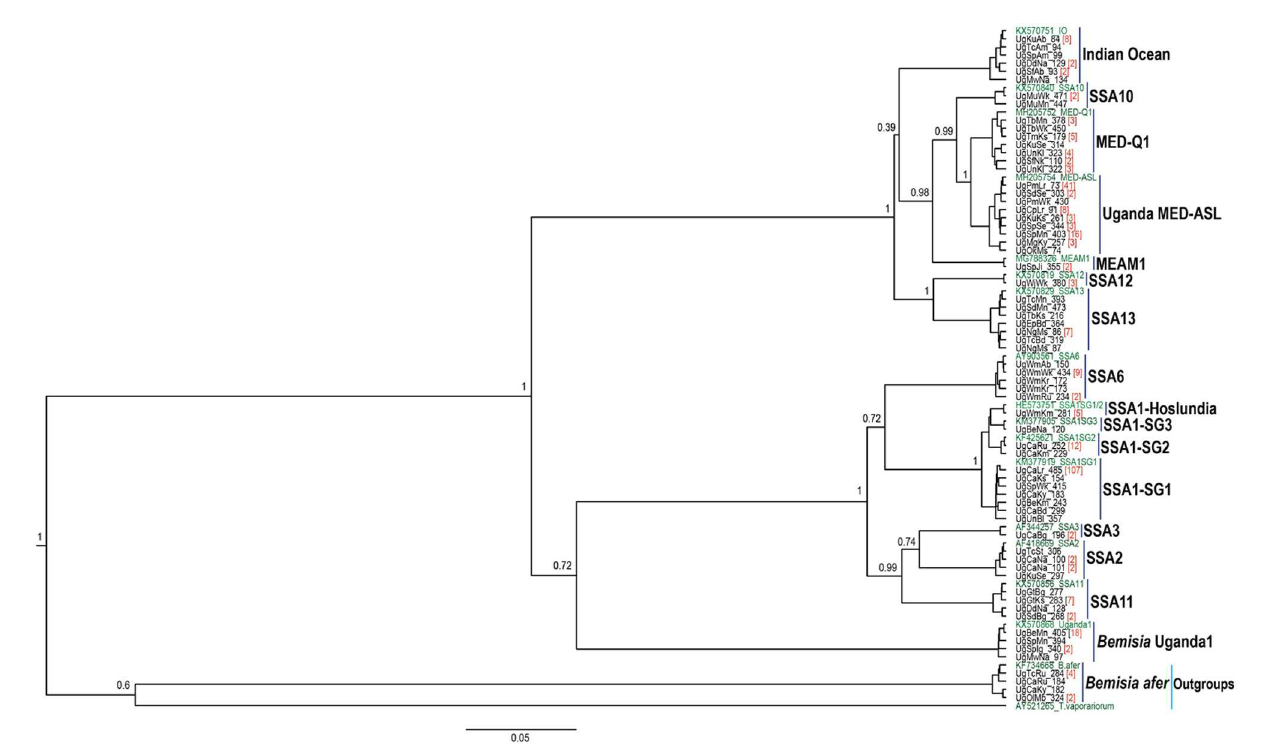
FIGURE2 BEAST2 phylogenetic tree based on partial mtCO1 sequences (657 bp) of adult B. tabaci species and other whitefly species collected from cassava and common host-plants during May/August 2017 in Uganda. Numbers noted at the nodes are posterior probabilities. Numbers in red besides a sample sequence are the number of individuals with that particular haplotype and in green are reference sequences.